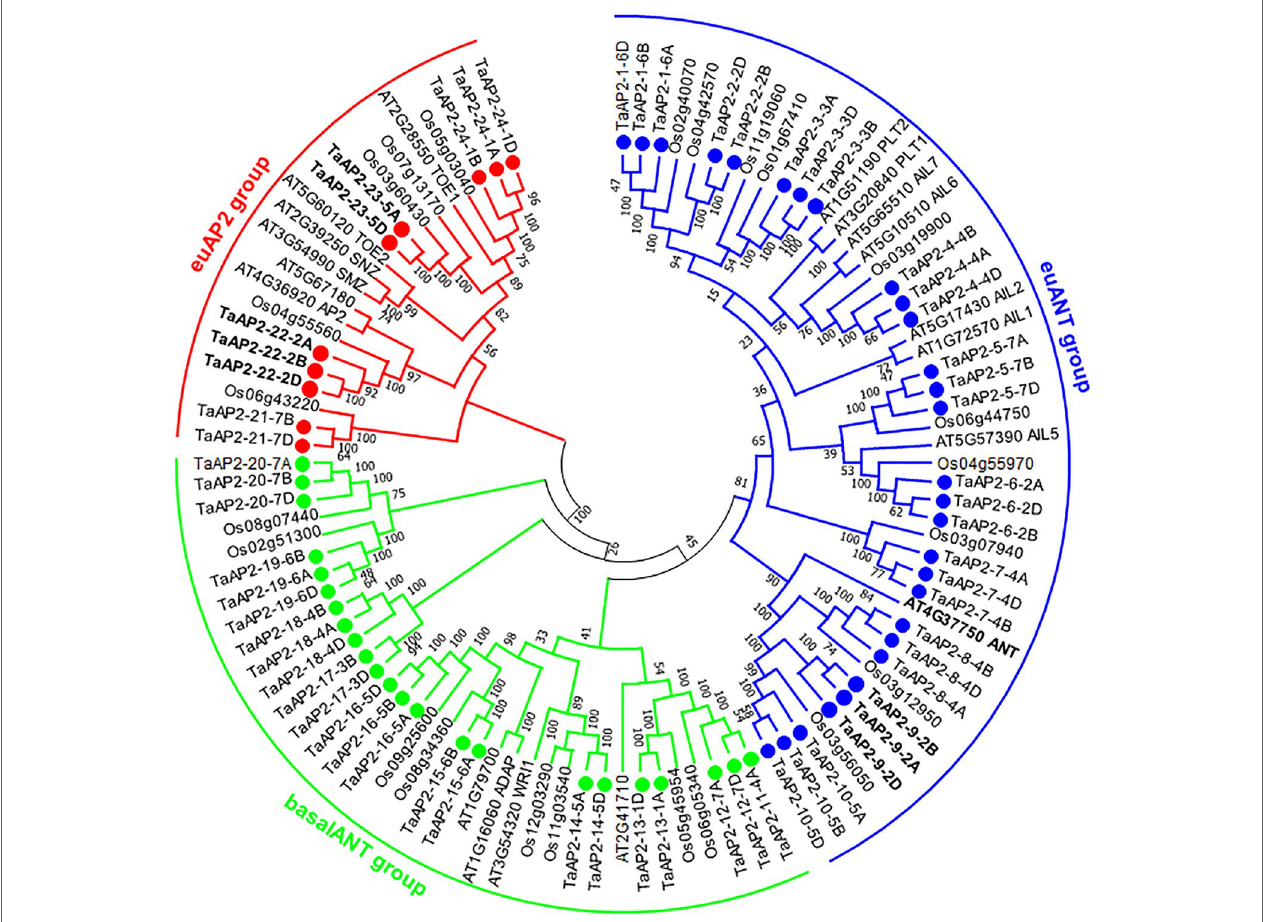
FIGURE 1 | Phylogenetic tree of AP2 proteins from wheat, Arabidopsis , and rice. The unrooted neighbor-joining (NJ) tree was constructed based on the AP2 proteins from wheat (62), Arabidopsis (18), and rice (23) using MEGA6.0. The numbers at nodes are bootstrap values after 1000 repetitions. The wheat AP2 TF proteins are named according to their positions in the tree. Each TaAP2 protein is indicated by a dot. The wheat AP2 proteins were classified into three groups, group euAP2, euANT, and basalANT, and they are represented by red, blue, and green, respectively. The three characterized TaAP2 genes and Arabidopsis ANT are highlighted in bold ( TaAP2-23 : Q; TaAP2-22 : TaAP2 ; and TaPARG : TaAP2-9